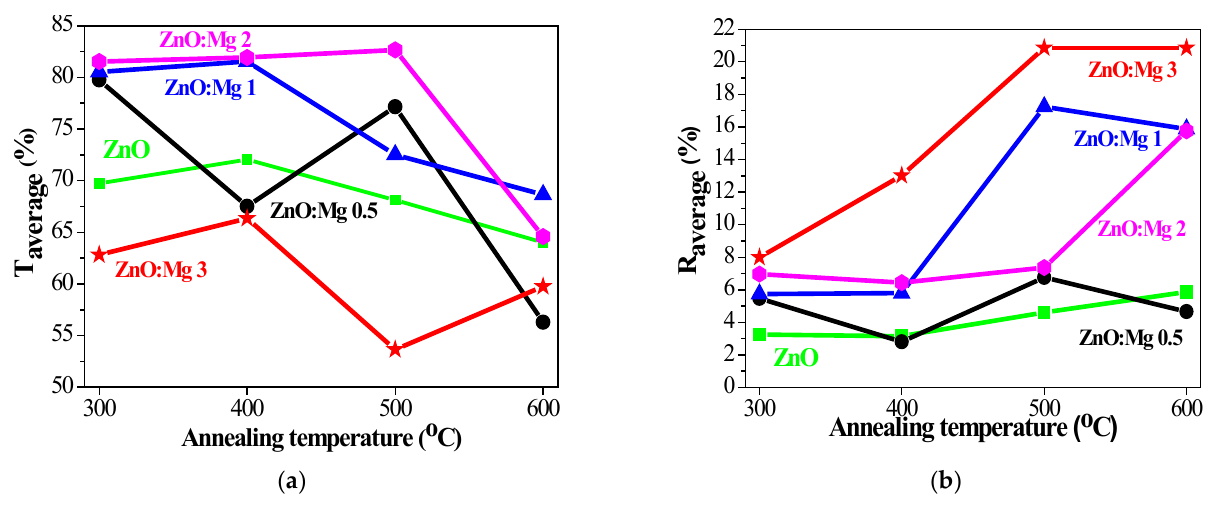
Figure 11. ( a ) Average transmittance (T average ) and ( b ) average reflectance (R average ) values estimated for the spectral range 450–750 nm of the sol–gel ZnO and ZnO:Mg films, depending on the annealing temperatures from 300 to 600 °C.